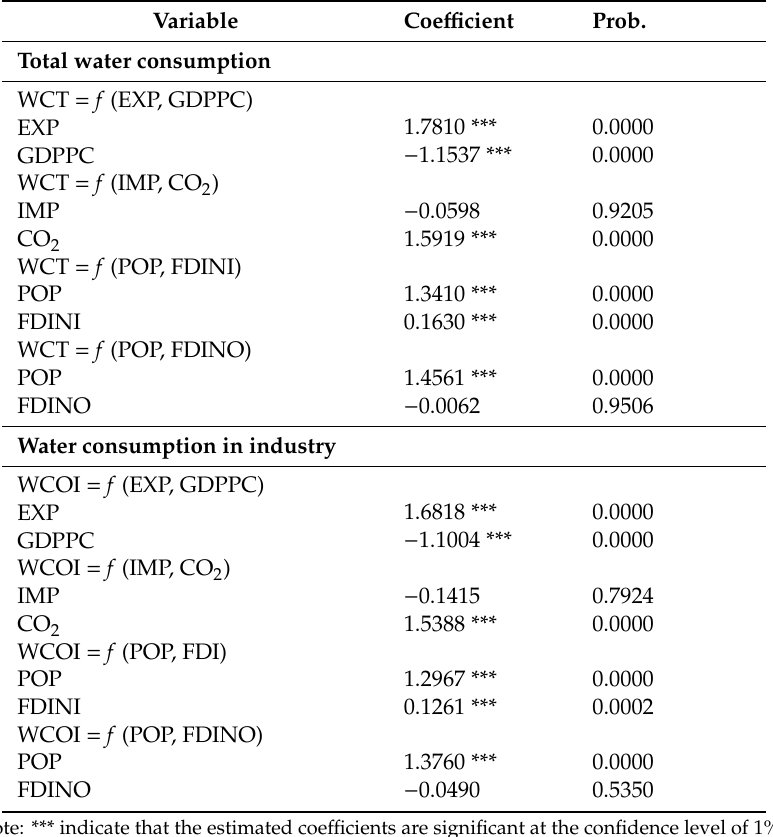
Table 10. FMOLS estimates and the long-run elasticities (Australia, Japan, and the UK). Variable